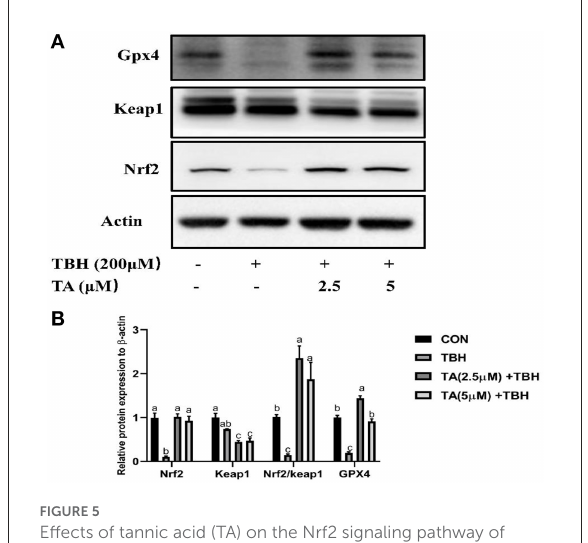
FIGURE5 Effects of tannic acid (TA) on the Nrf2 signaling pathway of IPEC-J2 cells. Western blotting analysis of the protein expression of Nrf2, Keap1, and GPX4 is shown (A) . Quantitative analysis of the protein expression of Nrf2, Keap1, and GPX4 (B) . Data are presented as mean ± SEM, n = 3. TA, tannic acid; TBH, tert-butyl hydroperoxide. a,b values in the same row not sharing a common superscript differ significantly.